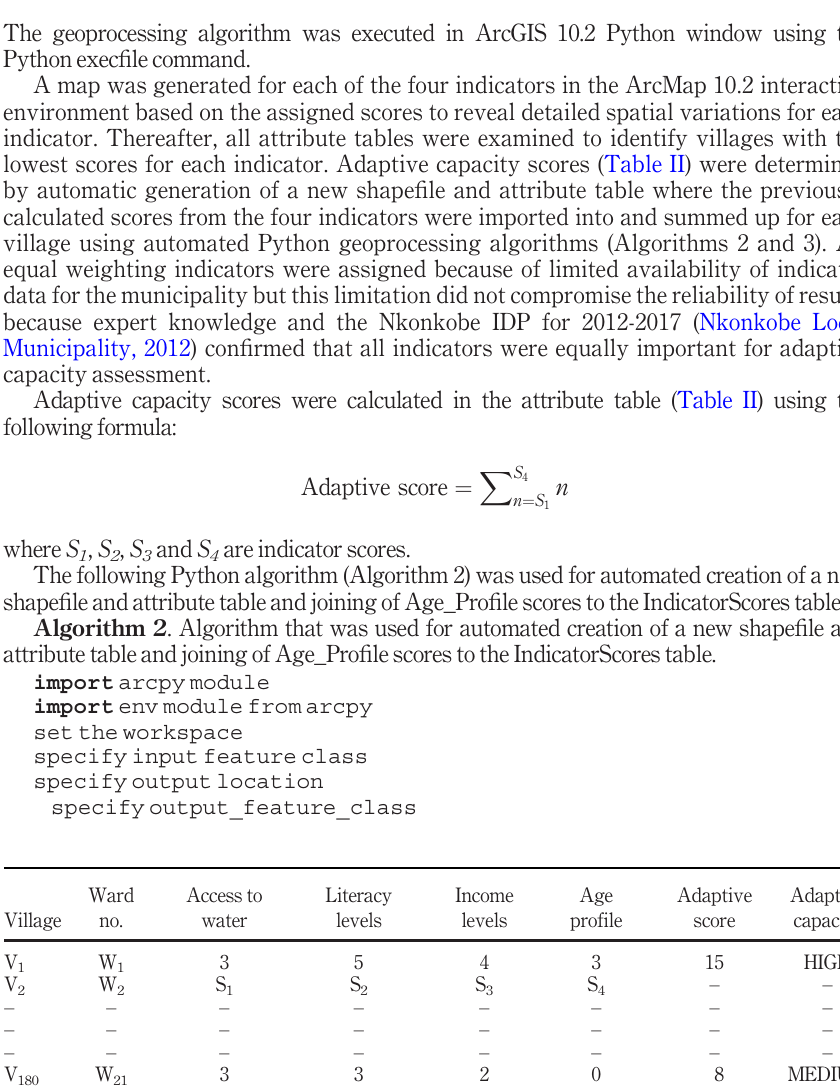
Table II. Illustration of the evaluation of adaptive capacity in the attribute